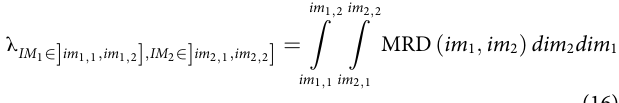
the proposed multi-hazard assessment, the partial rupture events for the tsunami